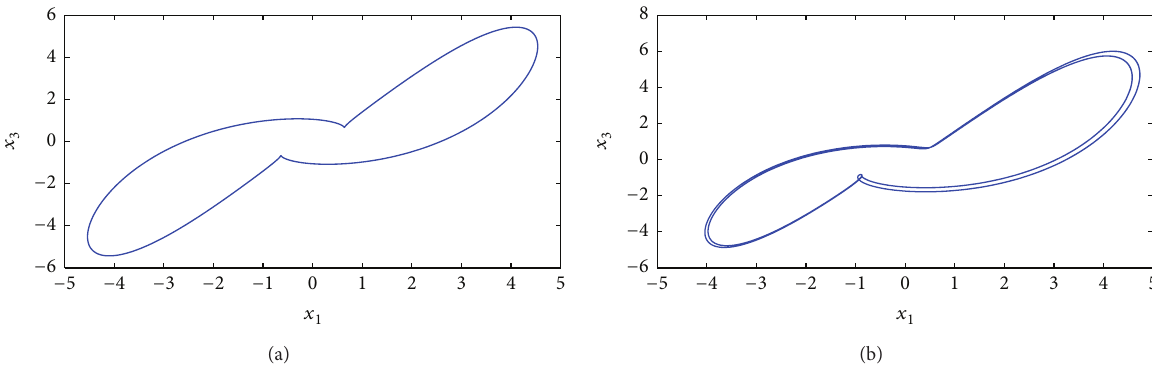
Figure 3: The phase portraits of the system for different values of the parameter 𝑎 : (a) the phase trajectory for 𝑎 = 7 and (b) the phase trajectory for 𝑎 = 5.8 .